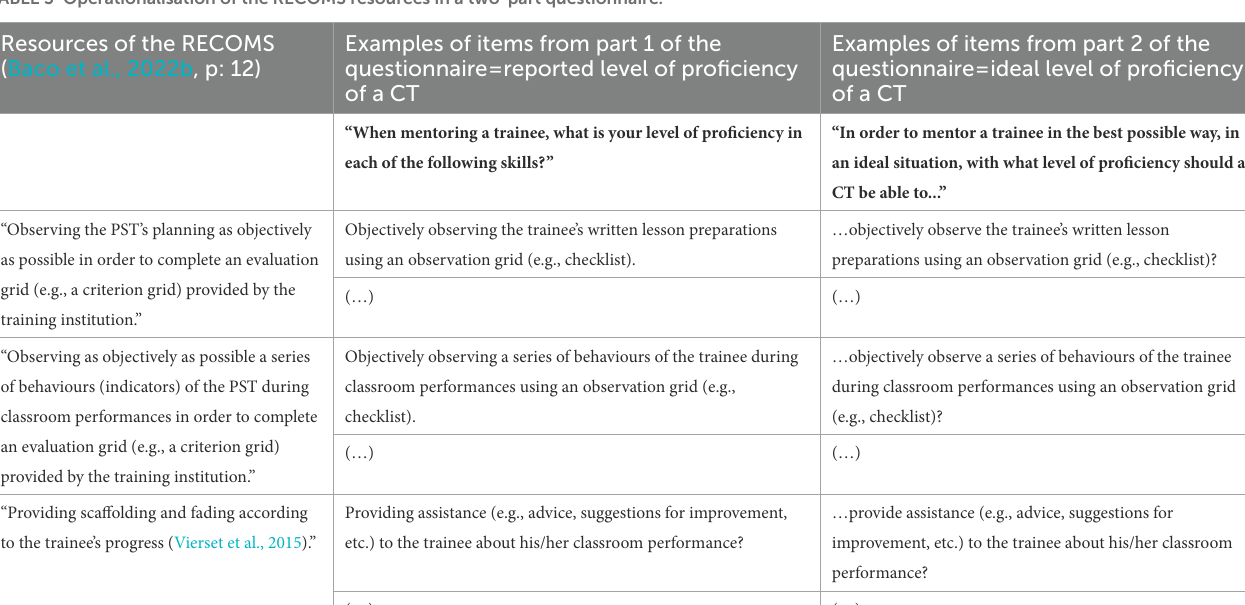
TABLE 3 Operationalisation of the RECOMS resources in a two-part